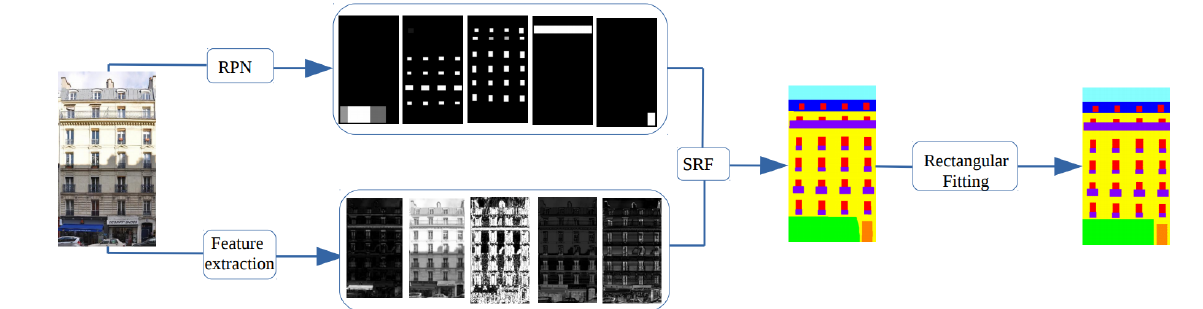
Figure 1. Architecture of the proposed pipeline for facade parsing (RPN – Regional Proposal Network, SRF – Structured Random